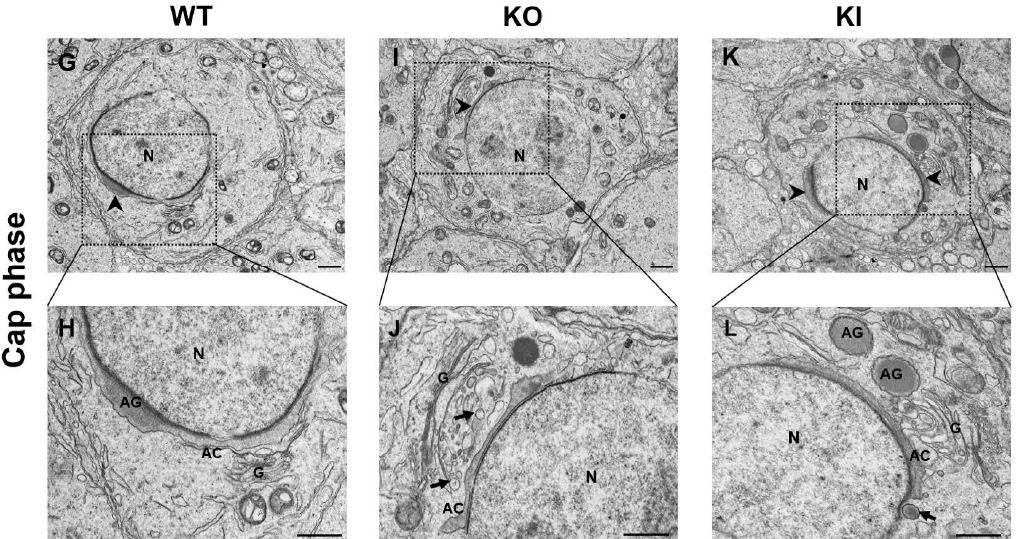
Figure 7. TEM images of developing RS in the testis of KO and KI mice show abnormalities in acrosome formation. WT RSs exhibit the characteristic developmental path of the acrosome. In the Golgi phase of RS of WT ( A , B ) proacrosomal vesicles indicated by arrows fuse to create a giant acrosomal granule (AG), which flattens along the acroplaxome and the nuclear envelope exhibiting a cap-shaped acrosomal structure in the cap phase ( G , H ). In the Golgi phase of RS of KO and KI, PVs are seen moving toward the nucleus and contacting the nuclear envelope, but they are unable to fuse to form a single AG. Hence, we notice multiple AGs ( C – F ). In the cap phase, the acrosome does not exhibit a typical cap-shaped structure and fails to flatten completely in both KO and KI RS. We still observe more than one AG and PV ( I – L ). AV: acrosome vesicle, AC: acrosome, AG: acrosome granule, G: Golgi apparatus, N: nucleus, PV: proacrosomal vesicles (indicated by arrows). Arrow heads indicate acrosome vesicle. Dotted regions of the images were shown in higher magnification below. The scale bar for low-magnification images is 1 μ m and for high-magnification images is 800 nm.